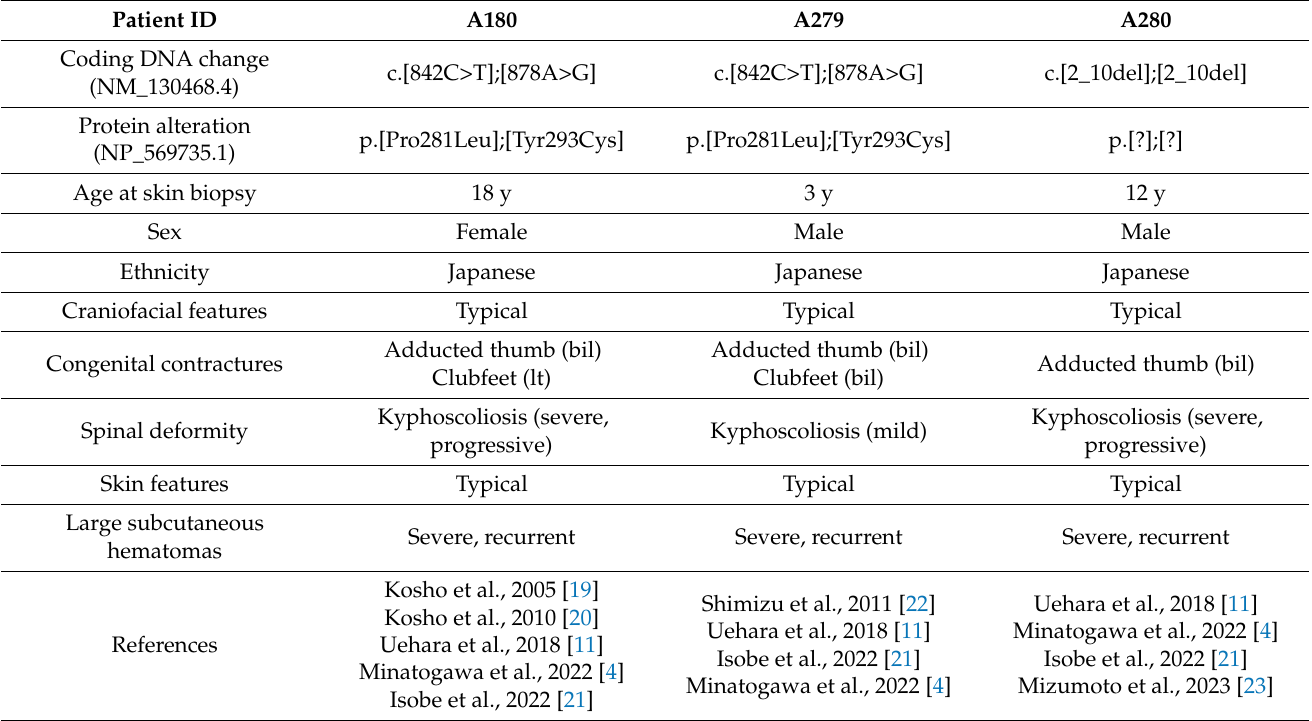
Table 1. Clinical and molecular information of the three patients with musculocontractural EDS (mcEDS)- CHST14